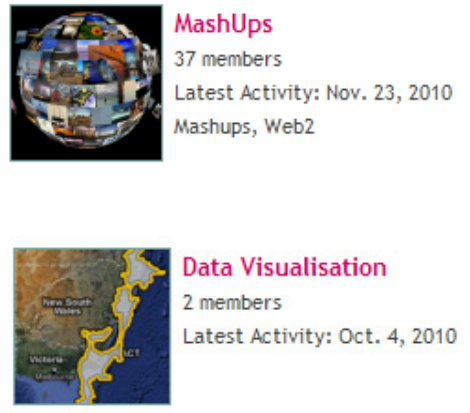
Figure 10. Screen clip of two teacher-di- rected groups. These were used for multiple classes of different ages and